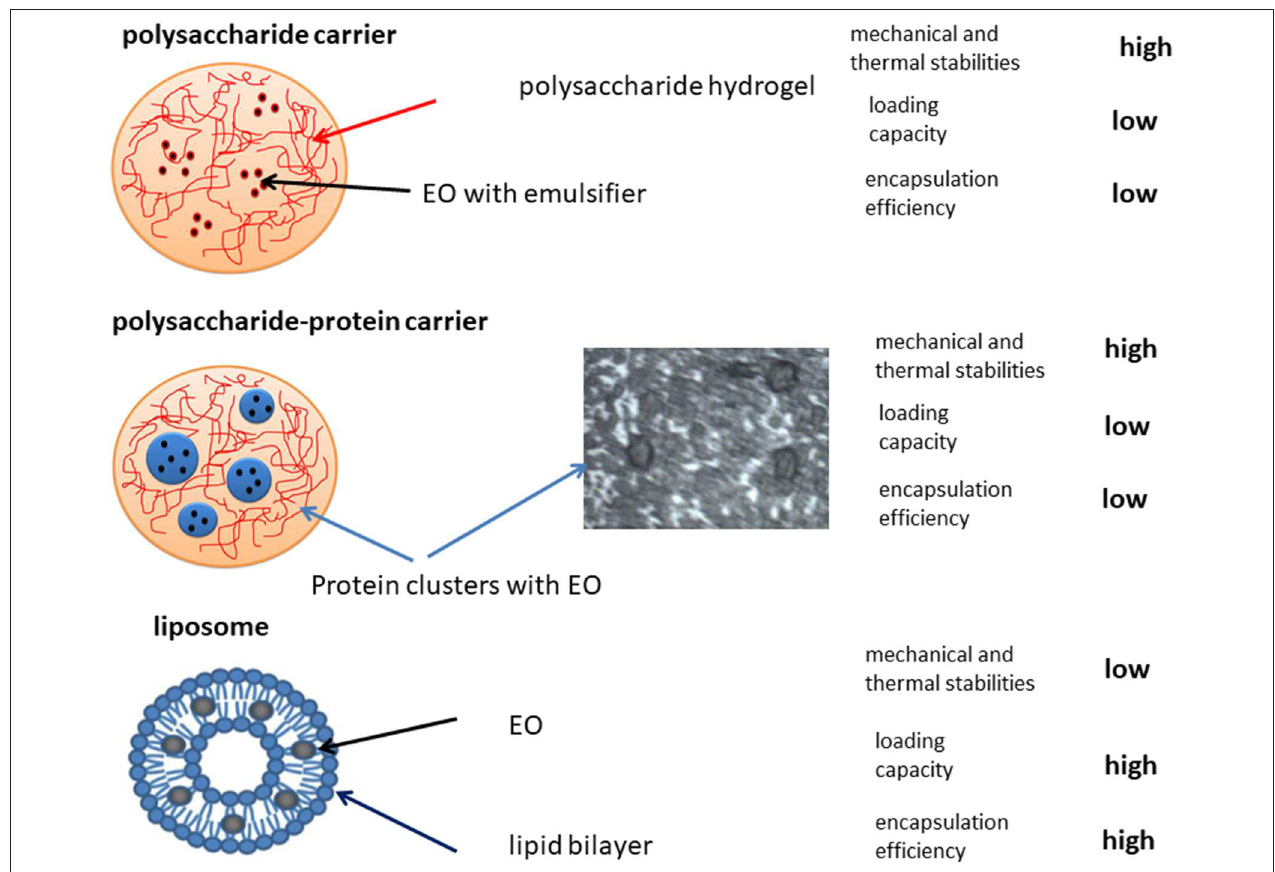
FIGURE 4 | Challenges in carrier selection for EO